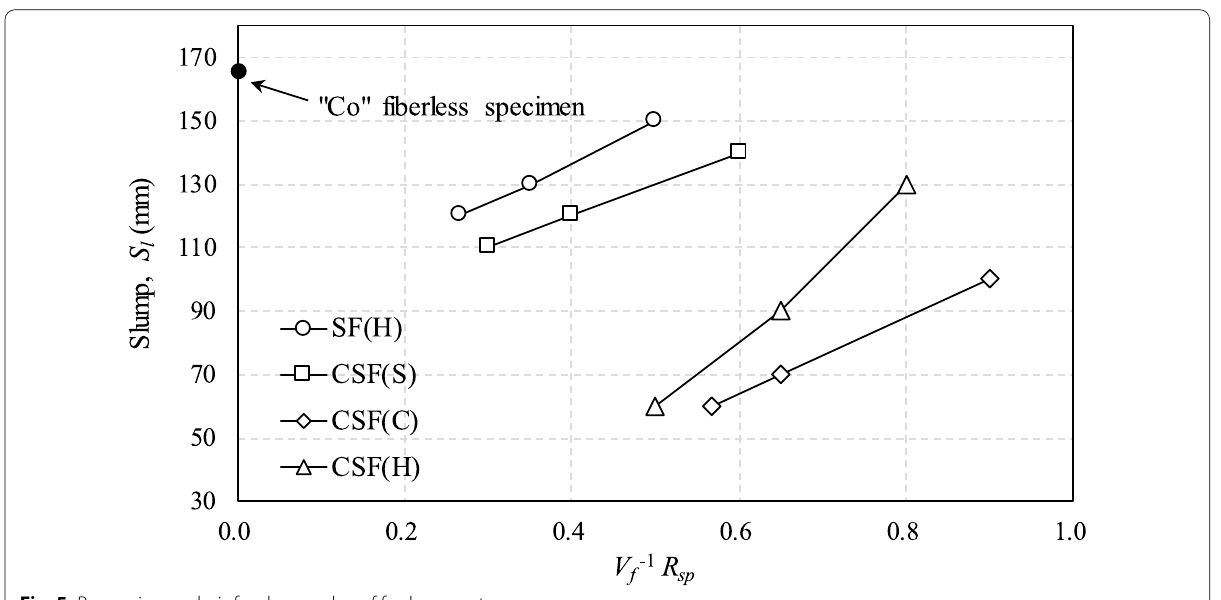
Fig. 5 Regression analysis for slump value of fresh